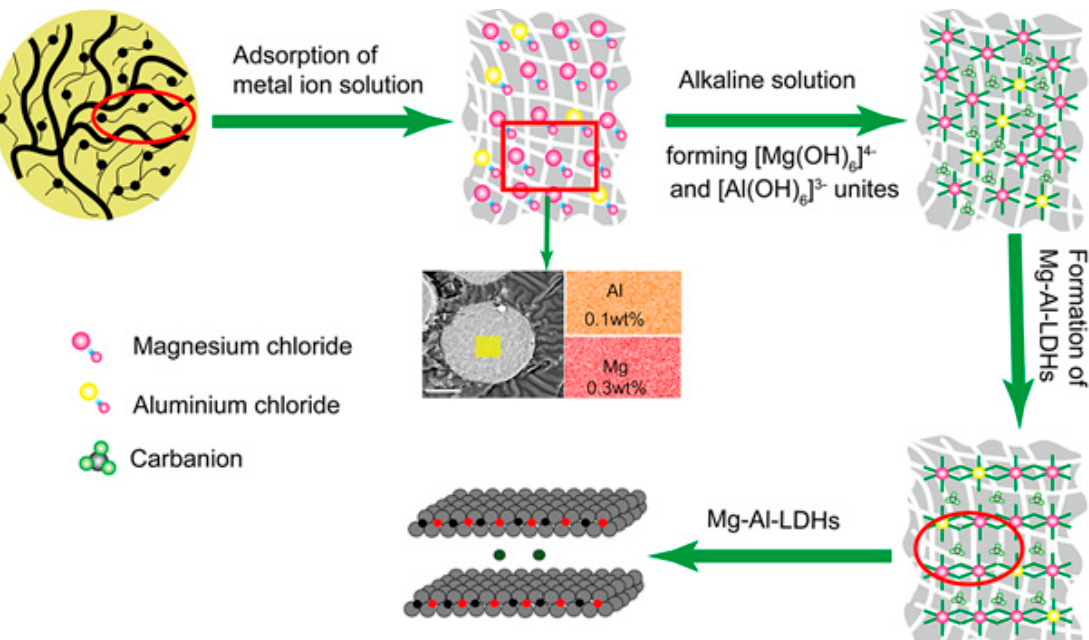
Figure 7. The synthesis mechanism diagram of Mg-Al-Hydrotalcite in the channel of silica matrix [33].